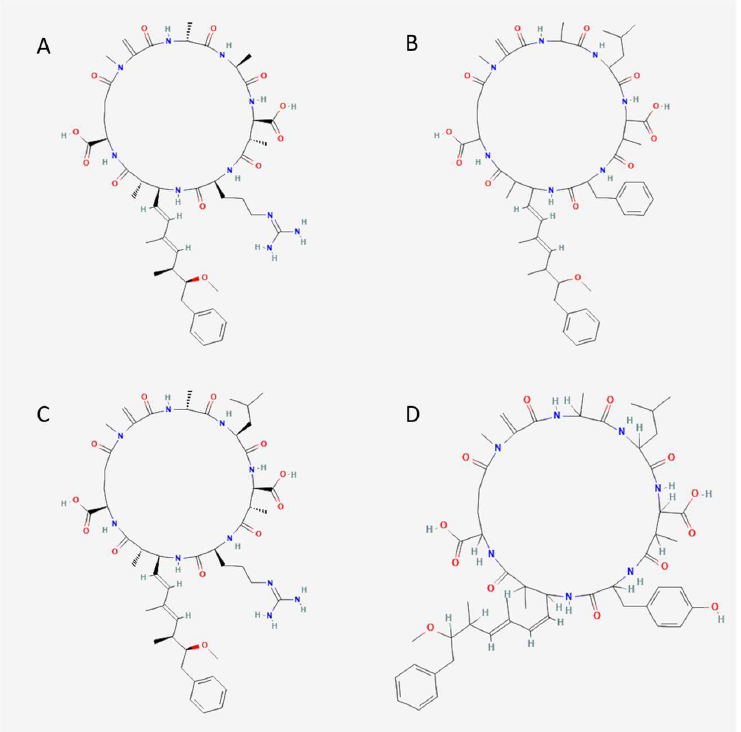
Figure 2. Microcystin congeners. ( A ) Microcystin-AR, ( B ) Microcystin-LF, ( C ) Microcystin-LR, ( D ) Microcystin –LY. Source: PubChem.